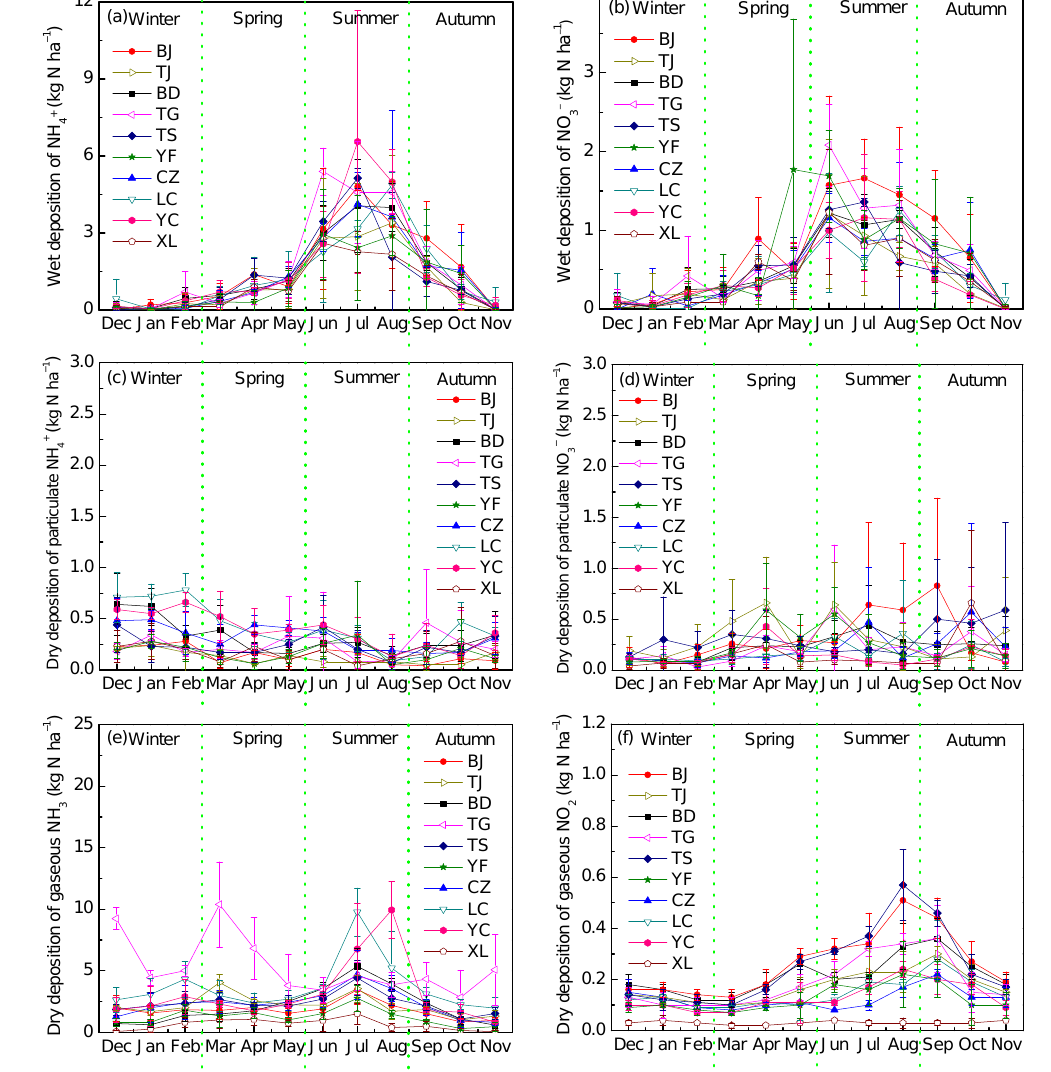
Fig. 3. Seasonal variations of the atmospheric deposition flux of nitrogen species at the ten selected sites in Northern China. The data shown are the monthly mean ± standard deviations of three-year observations (from December 2007 to November 2010). The definition of the site codes is found in the caption of Fig.